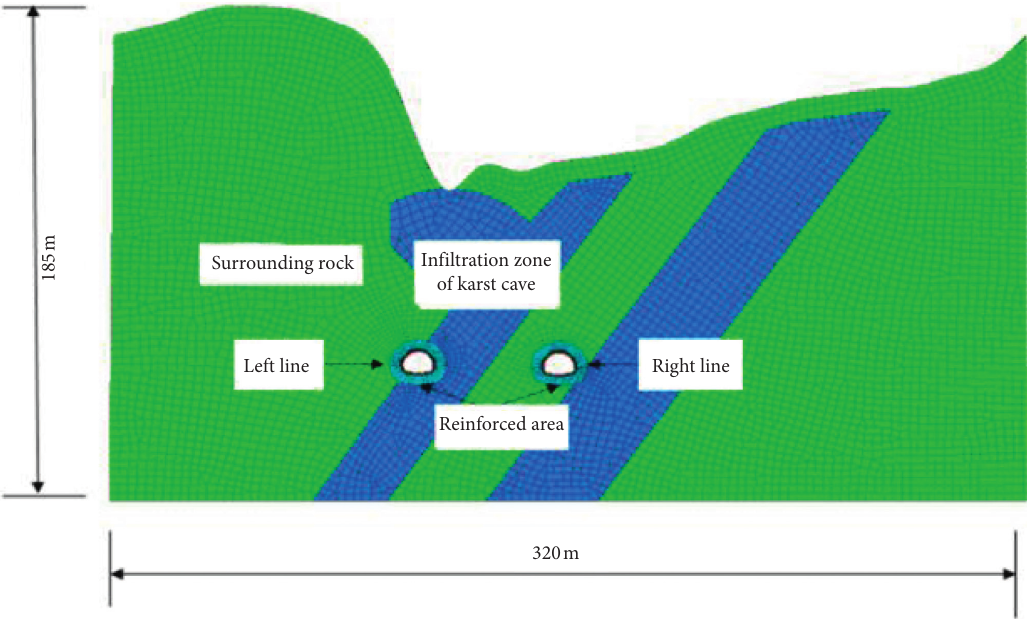
Figure 10: Numerical geological model.